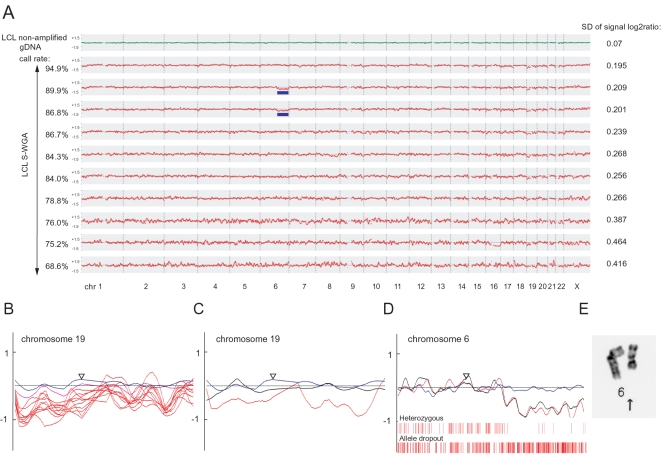
CCN analysis of the S-WGA products from the LCL samples.(A) CCN profiles of S-WGA products. Standard deviations of the signal log2 ratio are shown at the right. A genomic smoothing size of 2 Mb was used for analysis. Blue bars indicate the deletion in chromosome 6q. (B) CCN profiles of chromosome 19. Blue, pink and red lines indicate CCN data of non-amplified gDNA, WGA and S-WGA products, respectively. Profiles of 10 S-WGA products are shown. (C) Example of normalization of the CCN data of chromosome 19. The CCN data of chromosome 19 in an S-WGA product was normalized using the CCN data of the other nine S-WGA products as reference. Blue, red, and black lines indicate the CCN data of non-amplified gDNA, S-WGA product, and S-WGA product (normalized), respectively. (D) Example of the deletion of chromosome 6q in the S-WGA product. Weak signal log2 ratio of the 6q was still detected after normalization was applied (black line). Red bars indicate the location of the heterozygous SNPs in the non-amplified gDNA. Heterozygous and allele dropout indicate heterozygous and homozygous calls, respectively, on the array. (E) The result of karyotyping. Deletion of chromosome 6q was detected in 4 of 14 cells analyzed.